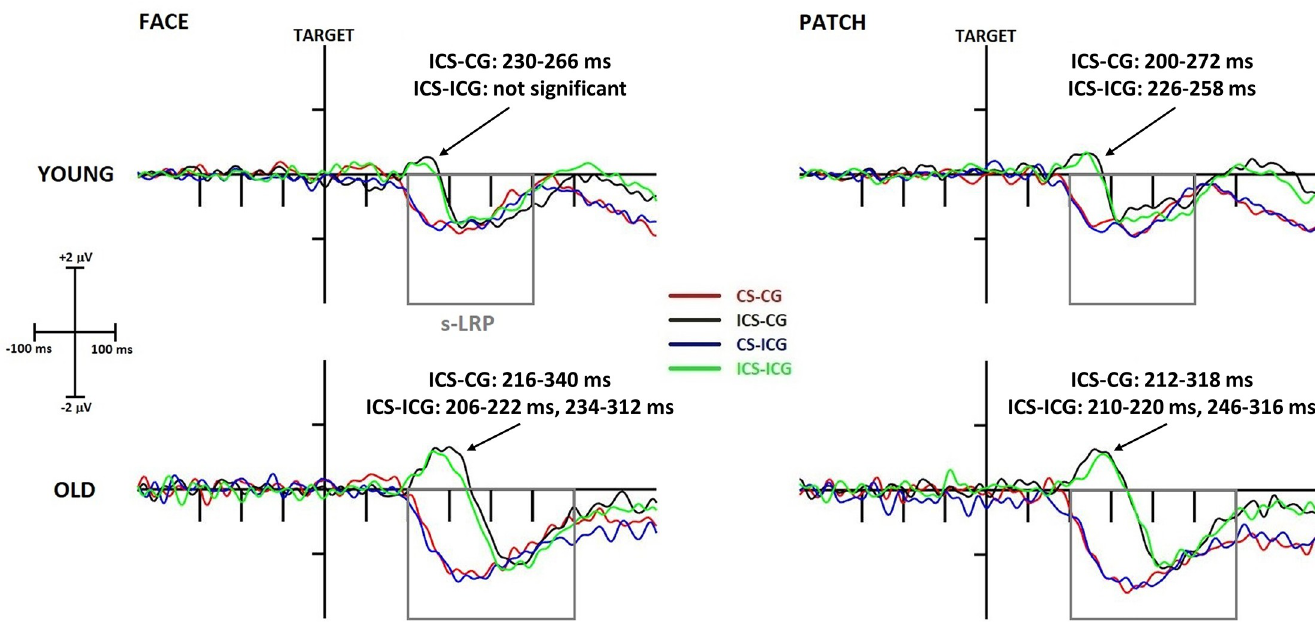
Fig 7. Stimulus-locked LRP component at the C3-C4 electrode difference (contra-minus-ipsilateral to the responding hand) in young (top panel) and older (bottom panel) adults and in face (left side) and patch (right side) trials. The x-axis represents the epoch from -450 ms to 800 ms around the time-point of target presentation. CS-CG (congruent Simon, congruent gaze) waveforms are displayed in red, ICS (incongruent Simon)-CG waveforms in black, CS-ICG (incongruent gaze) waveforms in blue, and ICS-ICG waveforms in green. The arrows show the positive dips of wrong side activation, and the latency ranges are indicated in which the t-test showed significant differences from the baseline in the 200–350 ms window. Grey rectangles represent the search window for maximal s-LRP amplitude in every subject.